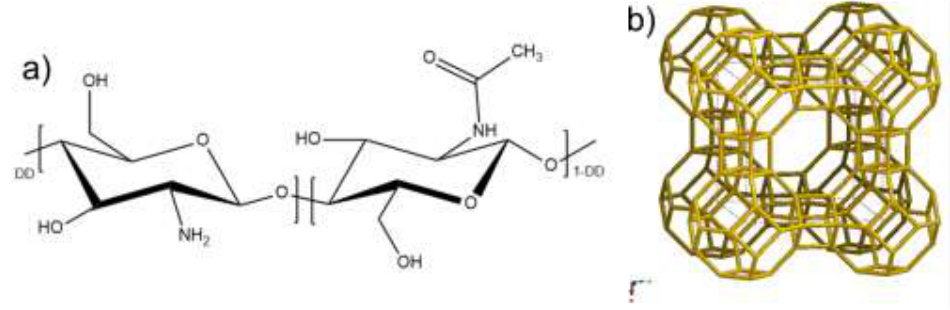
Figure 1. ( a ) Chemical formula of chitosan highlighting the glucosamine (left) and N-acetyl glucosamine (right) units (DD = deacetylation degree) and ( b ) crystal lattice of LTA zeolite (taken from the database of the International Zeolite